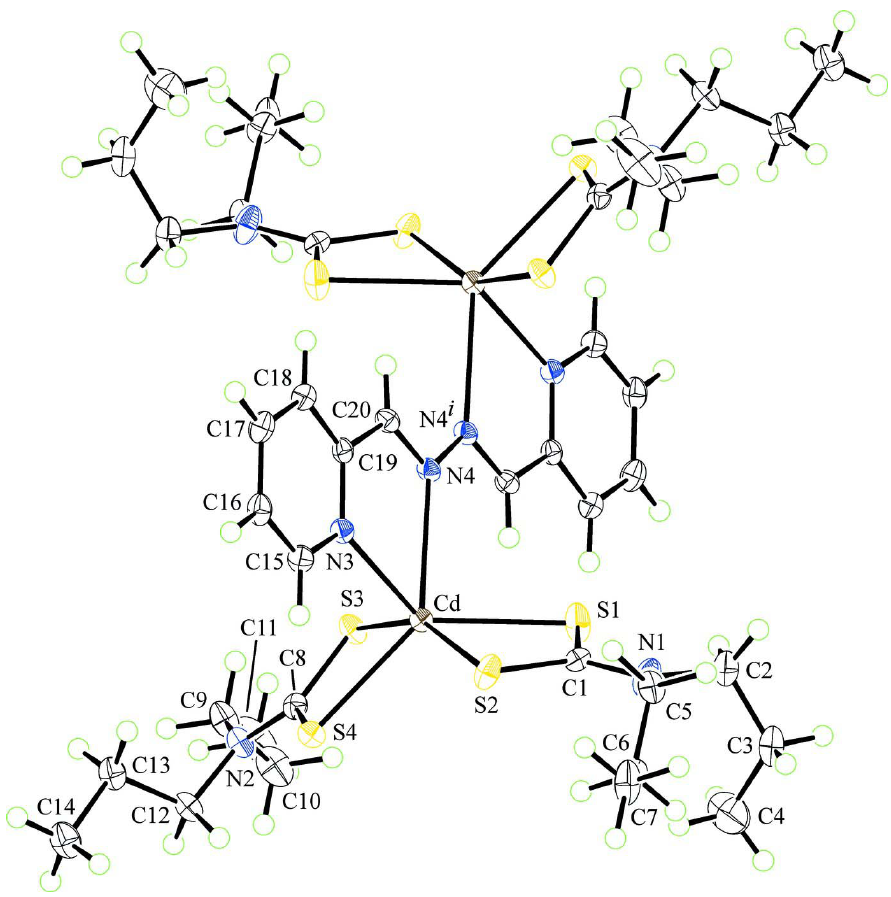
Figure 1 Molecular structure of (I) showing the crystallographic numbering scheme. Displacement ellipsoids are shown at the 50% probability level. Unlabelled atoms are related by the symmetry operation i: - x , 1 - y , 1 - z . The minor components of the disordered n-propyl groups omitted for clarity.